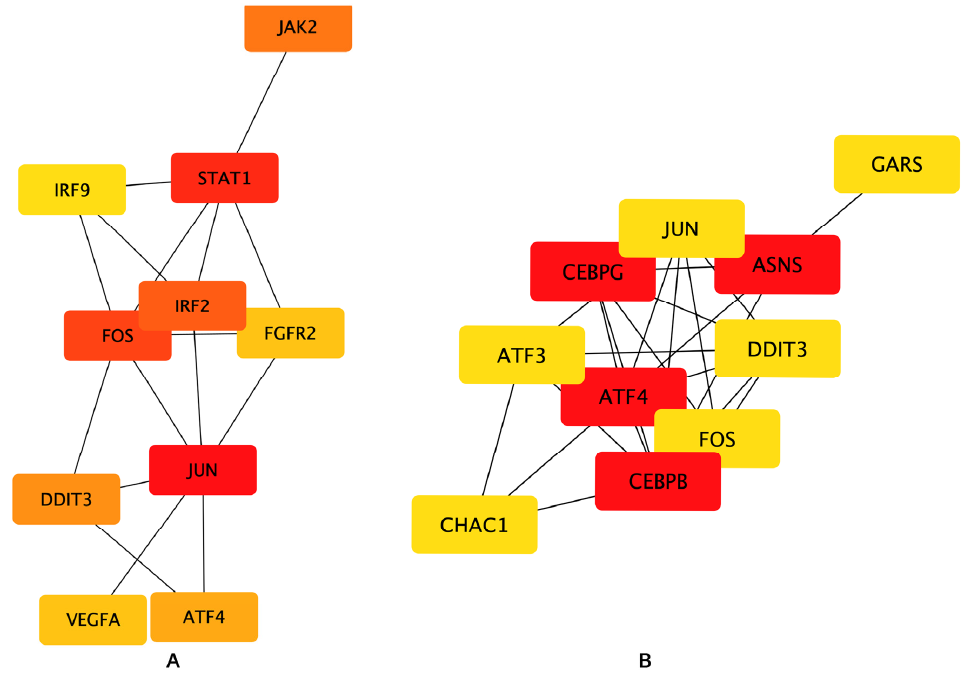
Figure 7. Hub genes network. The top 10 hub genes of the ( A ) Bottleneck and ( B ) EcCentricity algorithm were screened by the CytoHubba plugin. Higher rankings are indicated by deeper red colors.